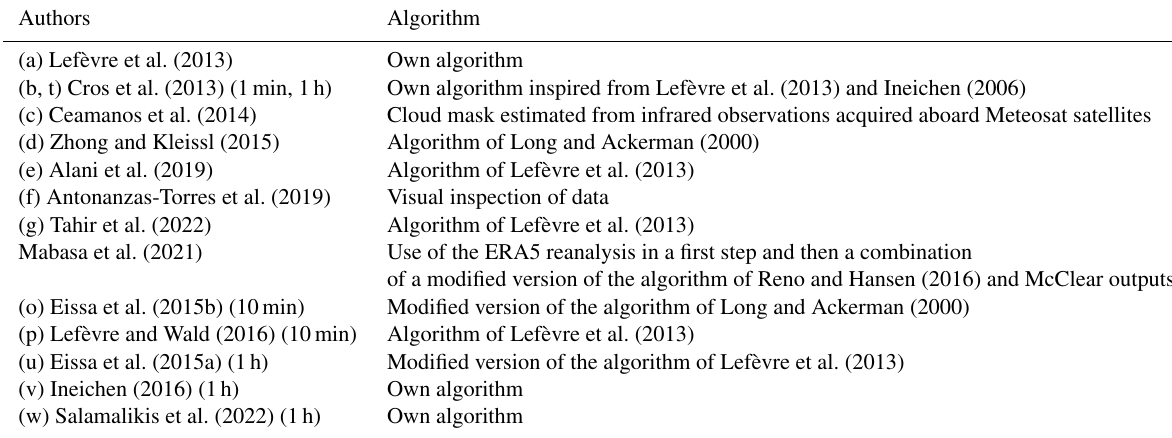
Table 14. List of algorithms used for detecting clear-sky instants.